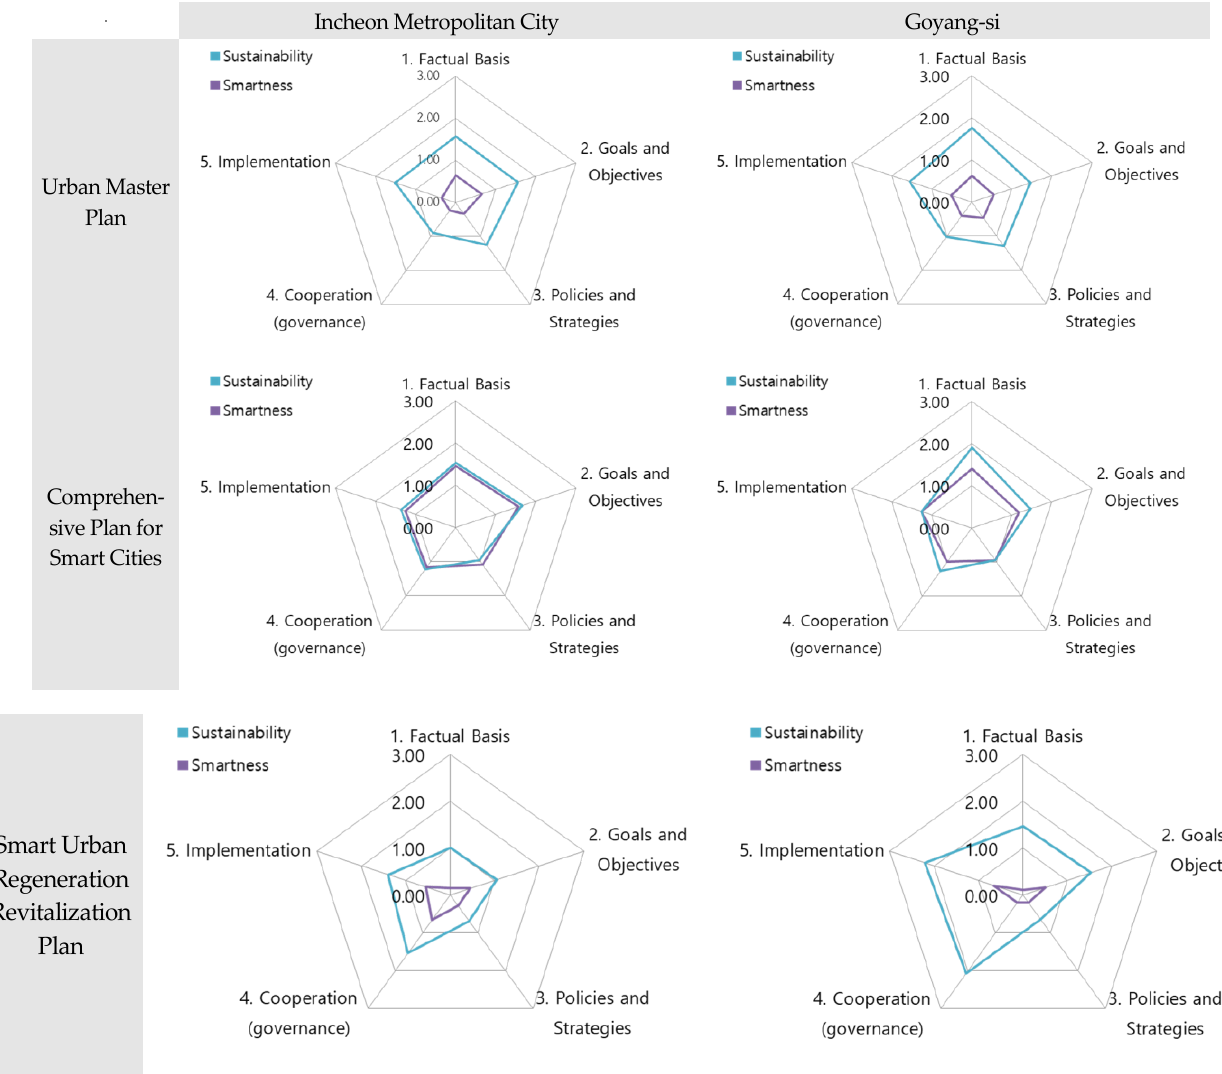
Figure 7. Sustainability and smartness score (main category) via plan. Table 2. Sustainability and smartness score (sub-category) via plan.